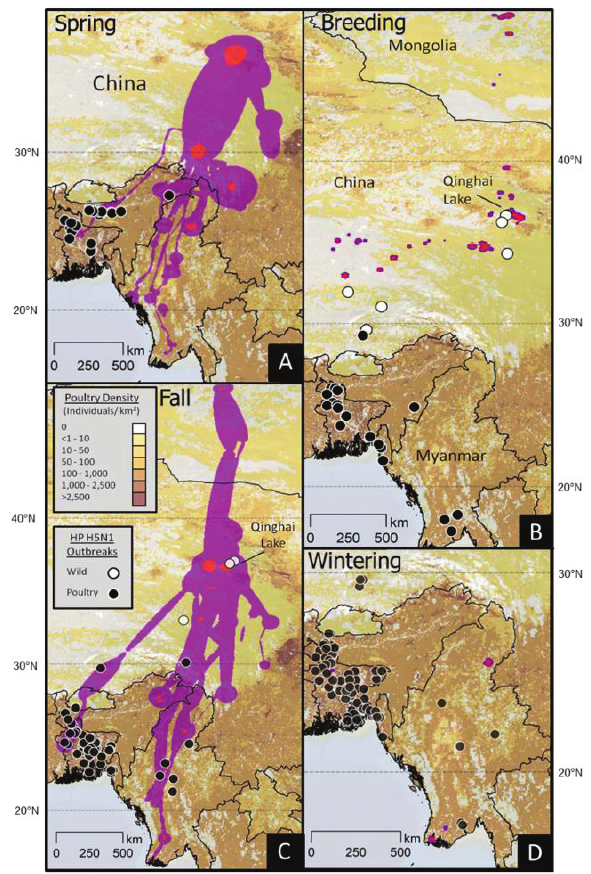
Figure 3. Utilization distributions for ruddy shelducks marked at Qinghai Lake, China, 2007 – 2008; shown in relation to poultry density (brown shading) and HP H5N1 outbreaks, occurring in wild birds (white circles) and poultry (black circles), from September 2003 to April 2010. Brownian bridge utilization distributions describe ( A ) spring (10 March – 4 May) and ( C ) fall (27 October – 20 December) migration movements. Fixed kernel home ranges depict population level ( B ) breeding (5 May – 26 October) and ( D ) wintering (21 December – 9 March) areas. Two shading levels (red, purple) for all utilization distributions indicate isopleths containing 95% and 99% of total locations,